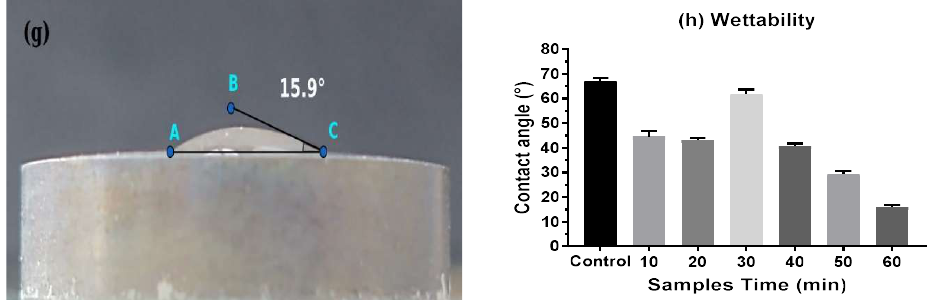
Figure 8. Contact angle of ( a ) the non-treated sample and anodized samples for 10, 20, 30, 40, 50, and 60 min, ( b ), ( c ), ( d ), ( e ), ( f ), and ( g ), respectively; ( h ) the behavior of the contact angle as a function of the anodization time. The water contact angles of the seven samples were 67.2 ◦ ± ◦ ◦ ± ◦ ± ◦ 40.8 1 , 29.4 1, and 15.9 1 . The non-treated sample showed the most extensive contact